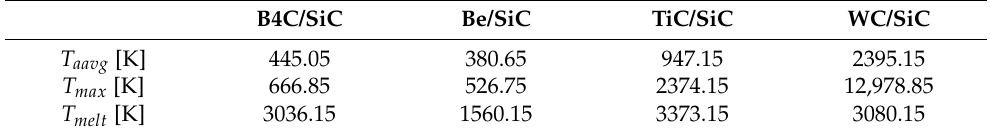
Figure 14. Temperature field in the z-x cross-section plane of MLLs consisting of ( a ) B 4 C/SiC, ( b ) Be/SiC, ( c ) TiC/SiC, and ( d ) WC/SiC multilayers with optimal thicknesses for diffraction, after 20 pulses of 1 mJ energy (10 J/cm 2 incident fluence). The simulation assumed that the incident X-ray beam illuminated only the area within the black dashed line box. Table 7. The highest average T avg and maximum T max MLL temperatures of different MLs for a photon energy of 17.5 keV and a train of 20 pulses with 1 mJ energy per pulse. B4C/SiC Be/SiC